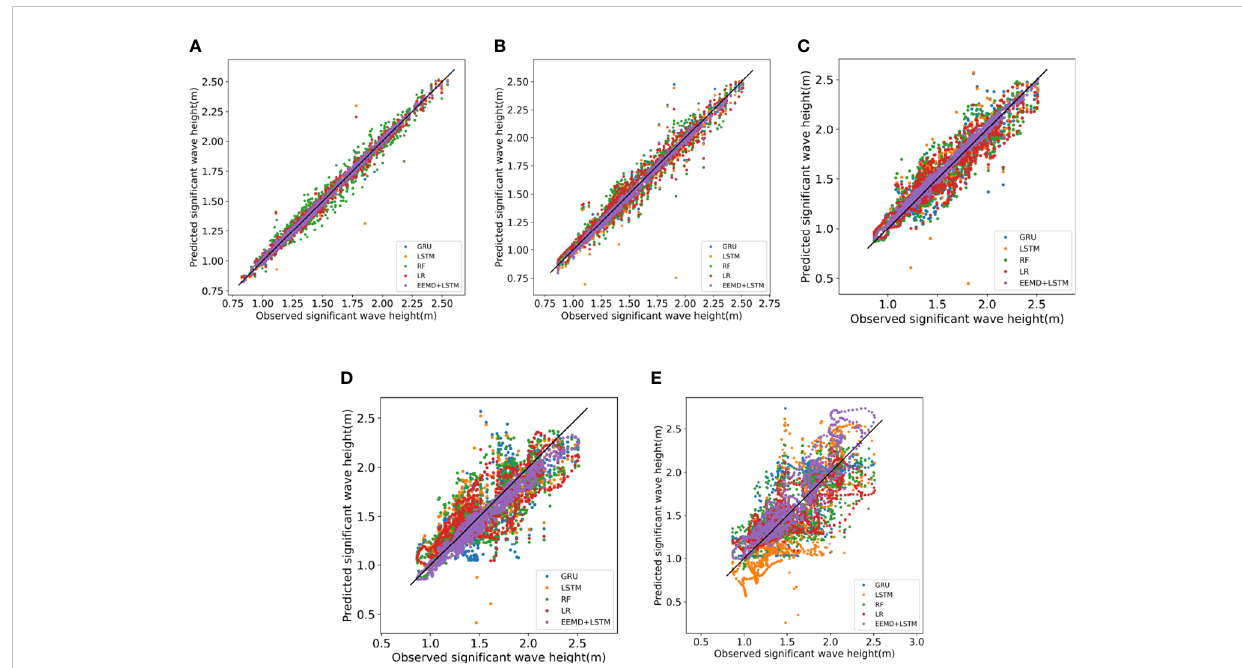
TABLE 6 Comparison of the prediction effect of PF and EEMD-LSTM models in predicting the SWH for the next 1 18 hours. Hours